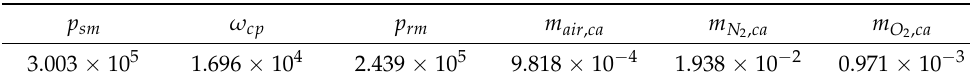
Table 3. Values of state variables in MPC algorithm.